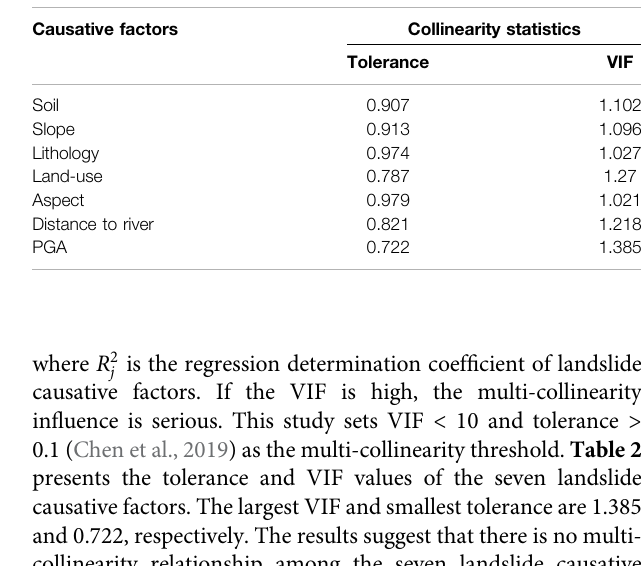
TABLE 2 | Multicollinearity analysis for the landslide causative